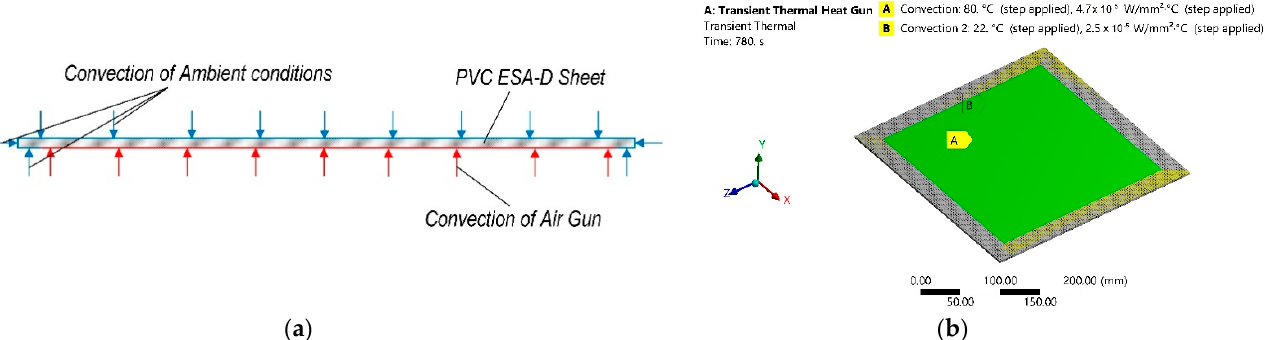
Figure 1. Transient thermal numerical analysis: ( a ) scheme; ( b ) computational model with boundary conditions. Table 2. FE numerical simulation data of the first stage of